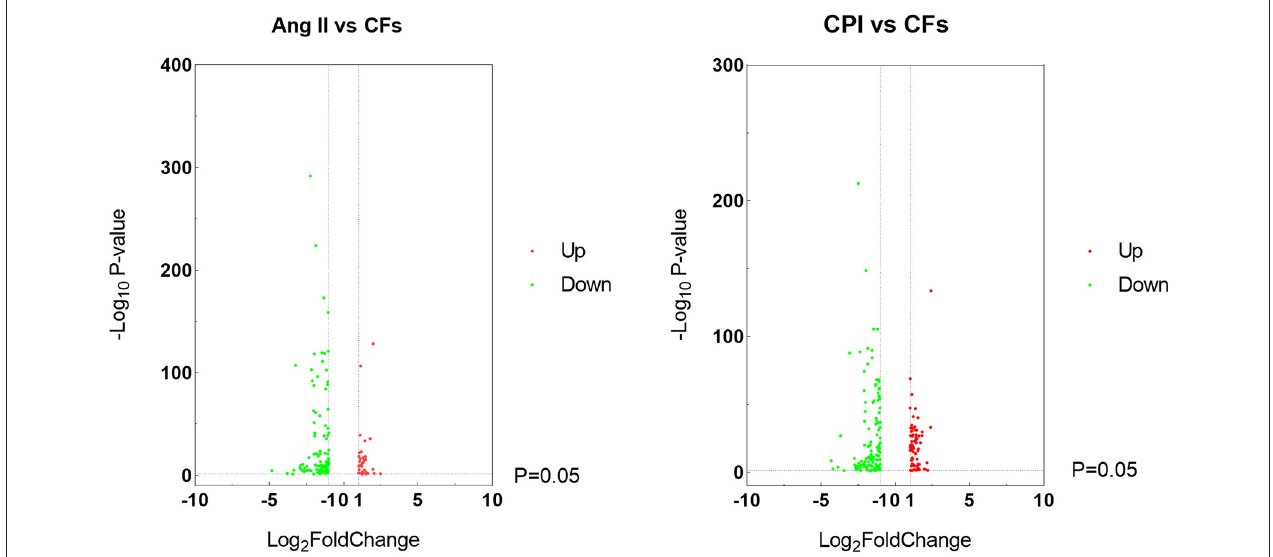
FIGURE 3 | Volcano plots of the genes that are DEGs in Ang II vs. CFs and CPI vs.